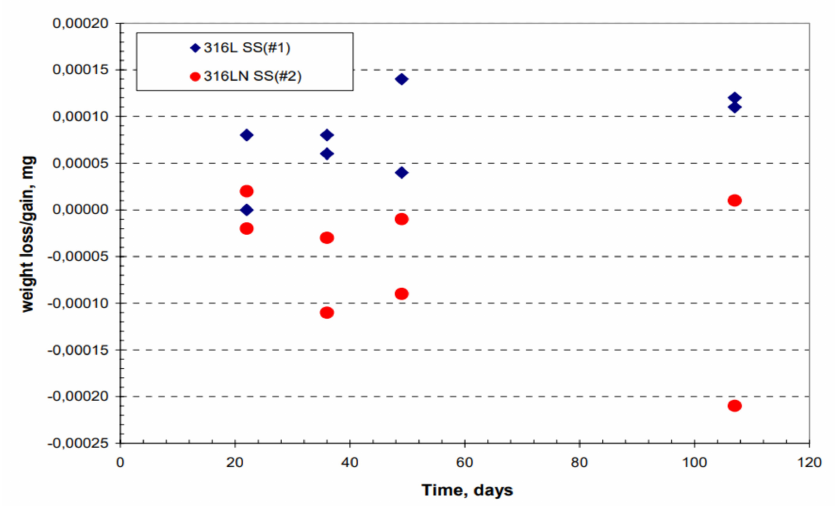
Figure 7. Weight gain/loss of plate specimens of 316L and 316LN exposed in simulated BWR environments under irradiation as a function of exposure time,